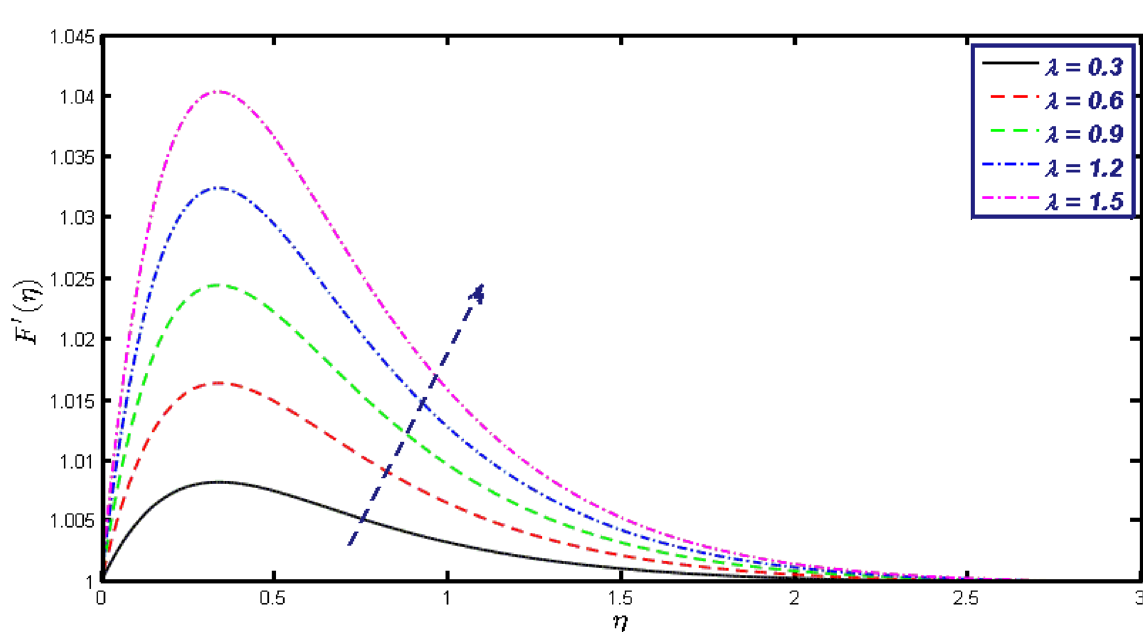
Figure 4. Velocity field for different values of (cid:31)